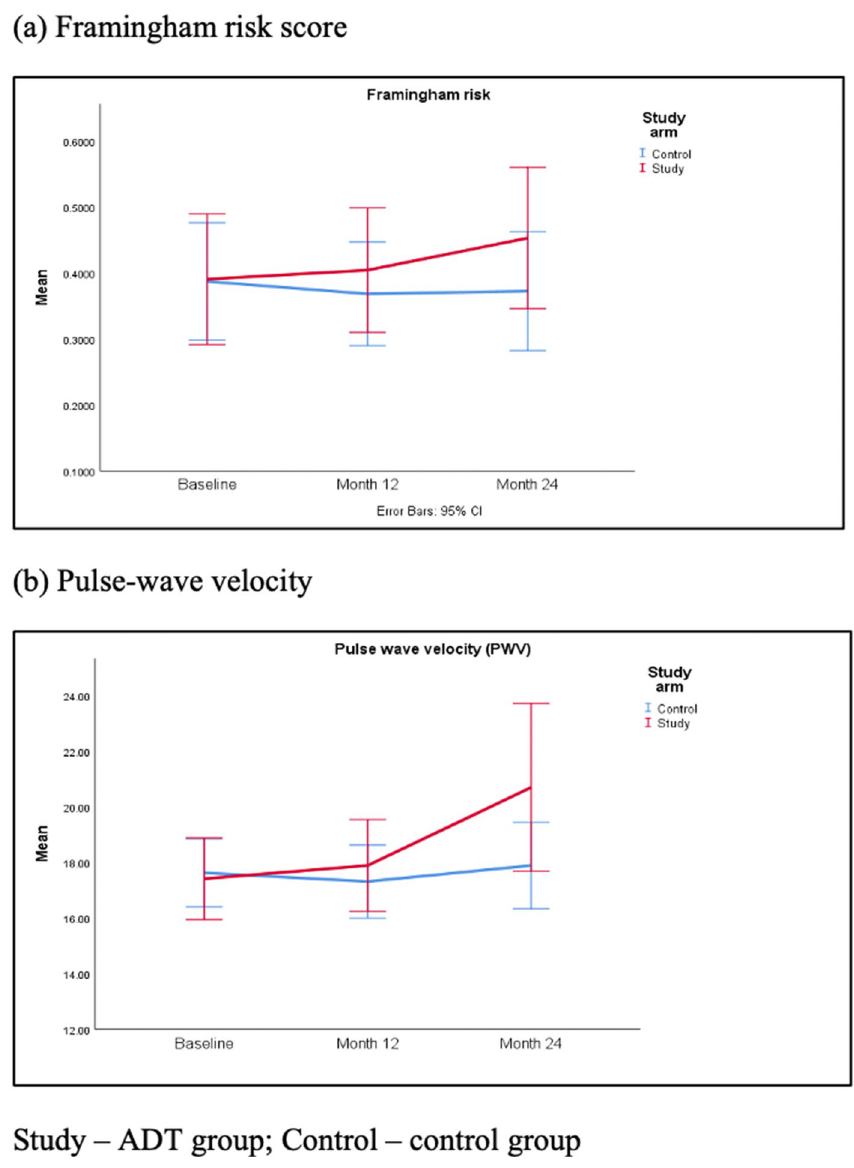
Figure 2. Changes in ( a ) Framingham risk score and ( b ) pulse-wave velocity over time for the two groups. Study ADT group, Control control